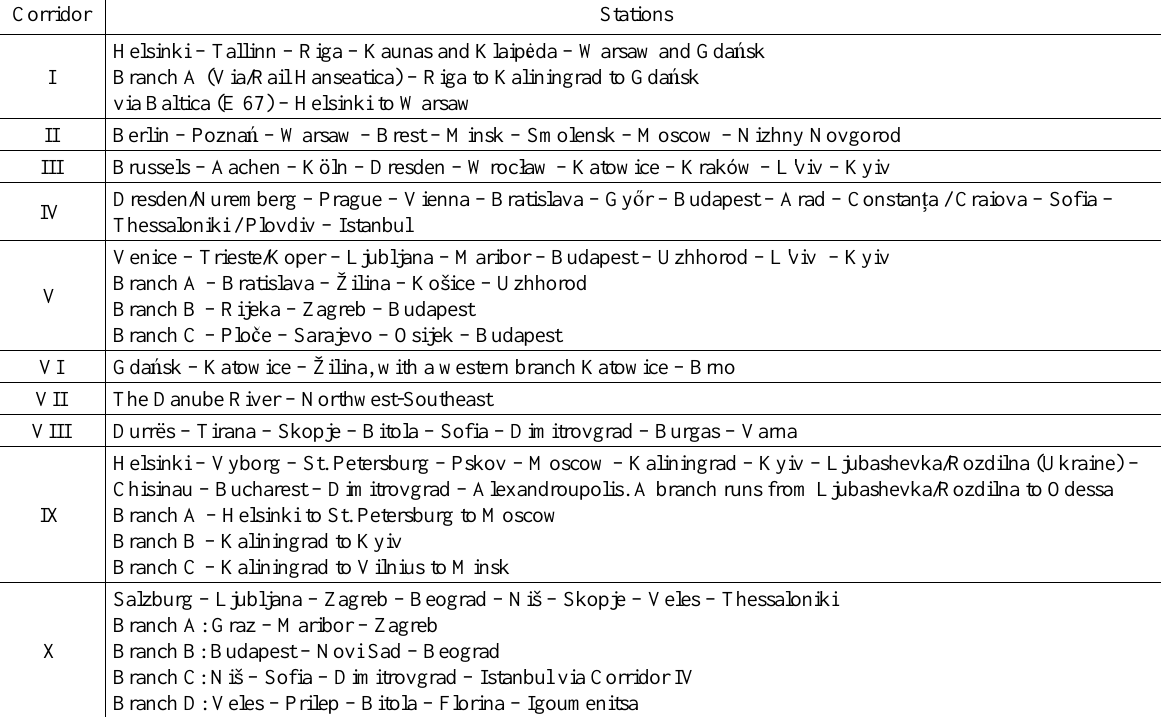
Fig 1. Pan-European corridors and areas